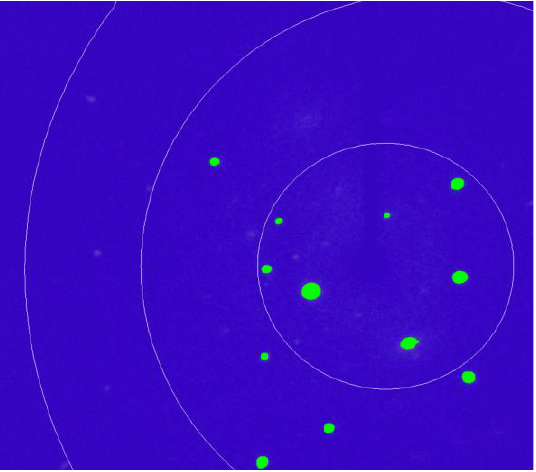
Figure 9. Contouring of the diffraction zone to digitalize their location by coordination on the image.